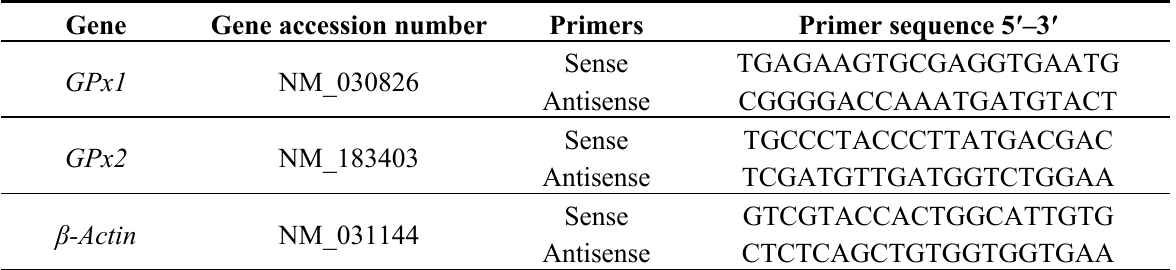
Table 2. Oligonucleotide primers used for real-time quantitative